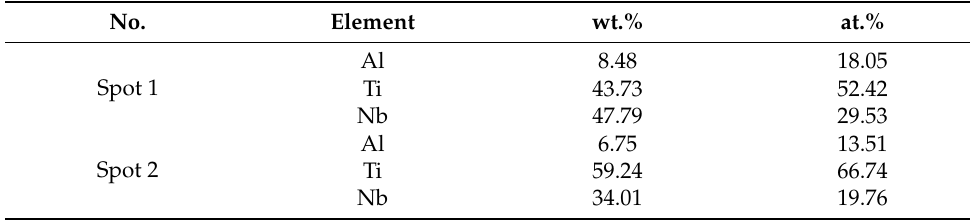
Figure 7. Microstructure of defect zone in the center by: ( a ) OM image at low magnification, ( b ) high magnification of zone A in ( a ) by SEM, and ( c ) high magnification of zone B in ( b ) by SEM. Table 3. EDS spectra of spots 1 and